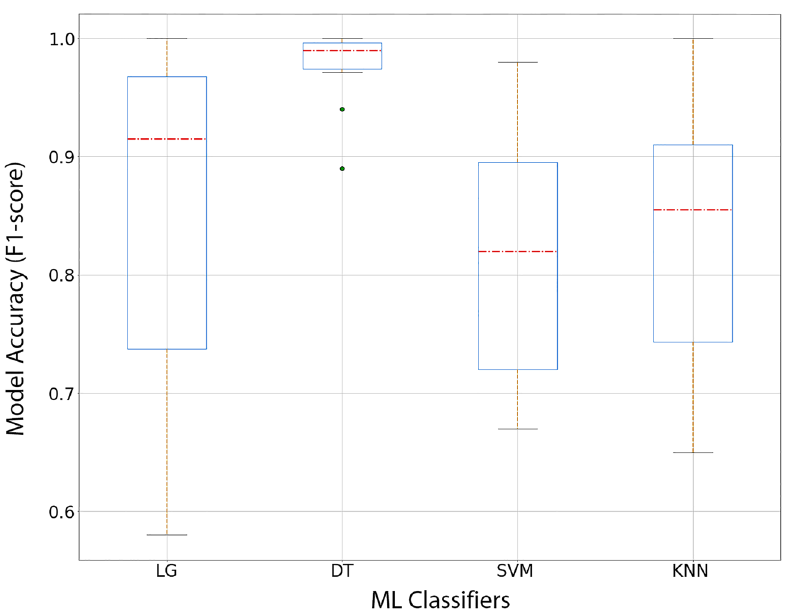
Figure 9. Distribution of the model accuracy (F1-score) in K-folds CV for the ML